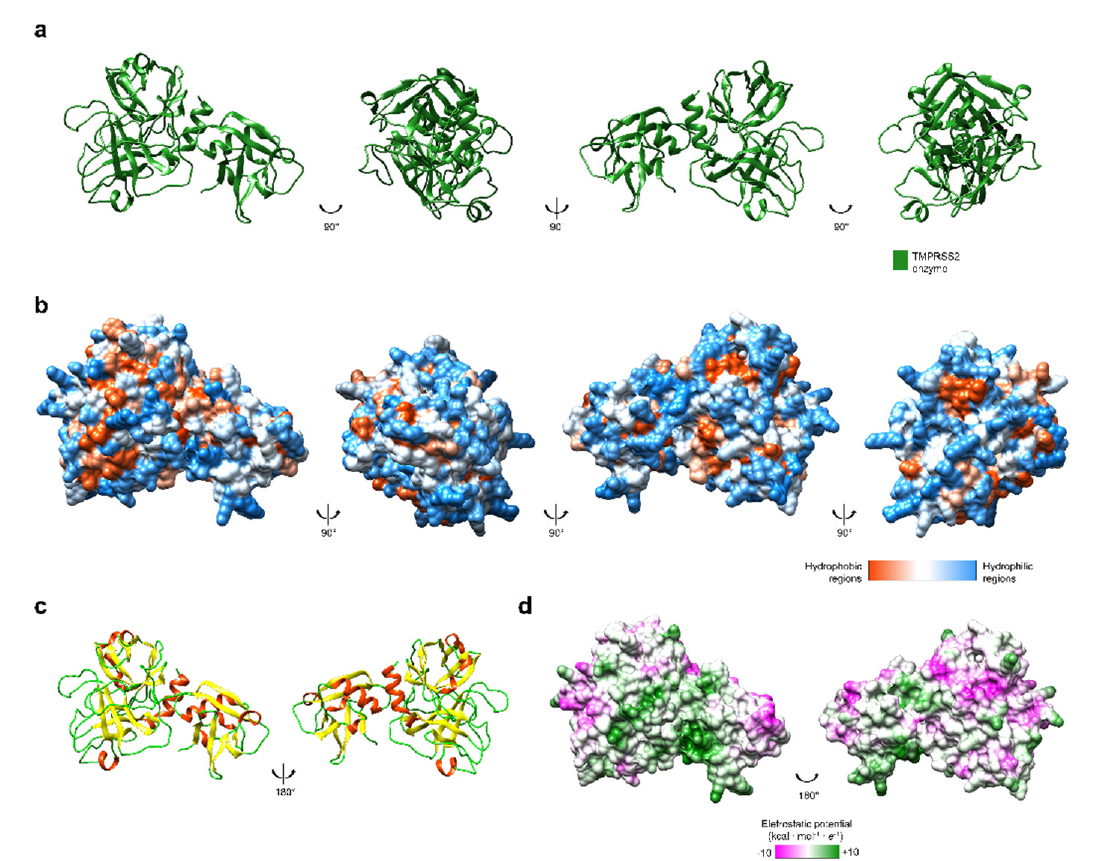
Figure 2. ( a ) Tridimensional structure of TMPRSS2 (UniProt structure identifier O15393 [27]). ( b ) Hydrophobicity surface colored following the Hessa and von Heijne hydropathic scale thresholds (dark orange most hydrophobic; white 0; aquamarine most hydrophilic) as described by Hessa et al. [23]. ( c ) The secondary structure is colored in red (helix), light green (random coil), and yellow (strand). ( d ) Electrostatic surface colored according to Coulombic electrostatic potential, e = 4r, thresholds ± 5 kcal · mol − 1 · e − 1 − at 298 K. Molecular graphics and analyses performed using the UCSF Chimera package software [24].